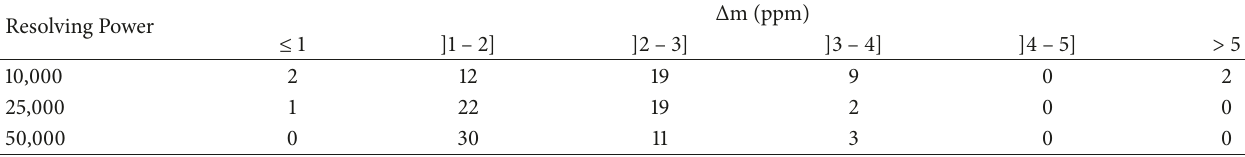
Table 4: Number of ions (diagnostic and fragment ions) into the six mass accuracy ranges considered at 10,000, 25,000, and 50,000 FWHM. Resolving Power